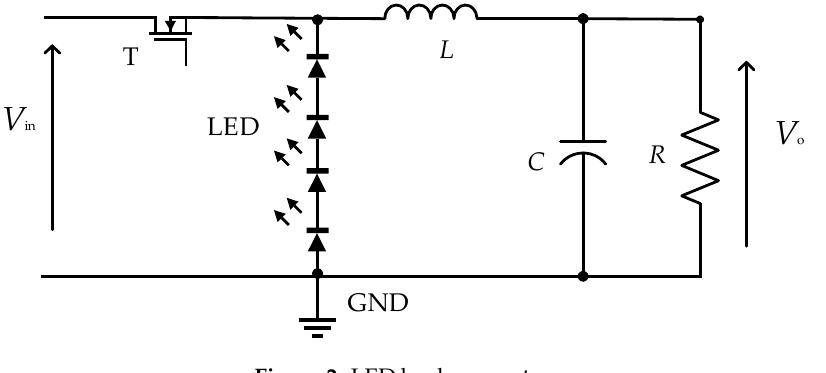
Figure 2. LED buck Figure 2. LED buck converter.